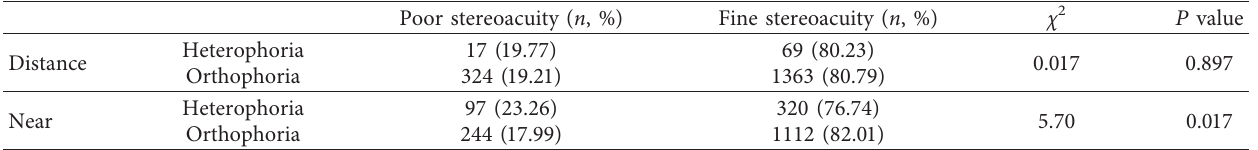
Table 6: Proportion of children with/without fine stereoacuity ( ≤ 60seconds of arc) in heterophoric and orthophoric children for grade-one pupils at near and distance fixation in Lhasa, Tibet Autonomous Region, China.